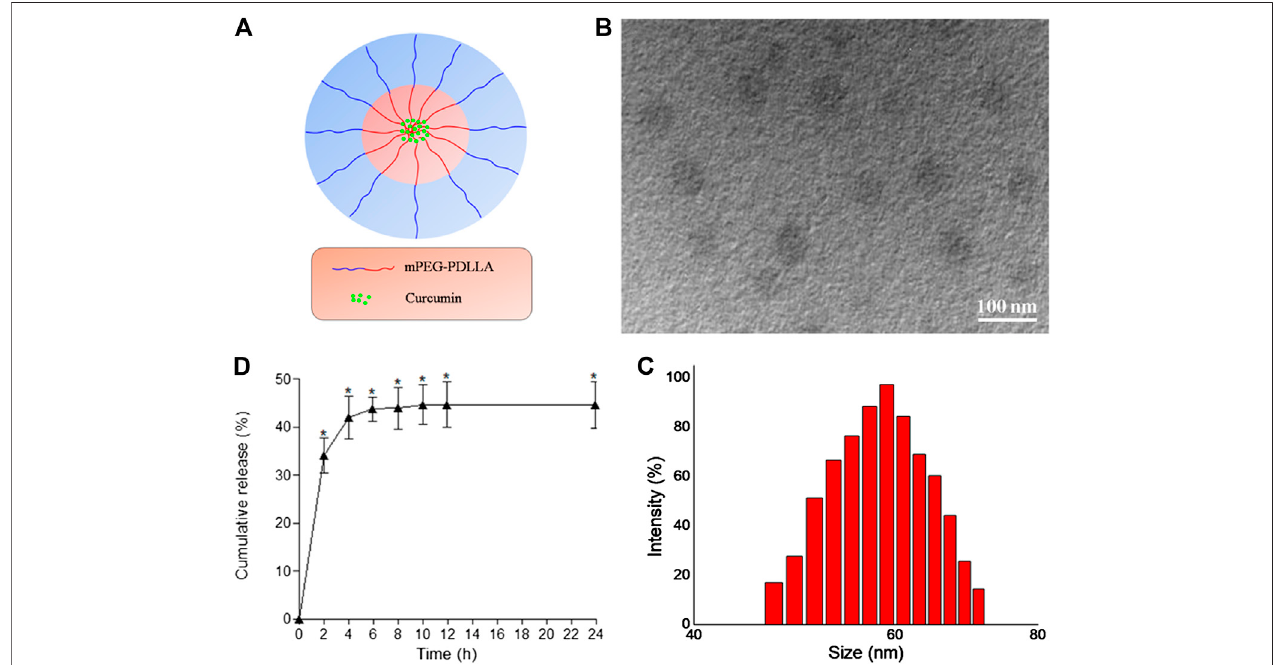
FIGURE1| CharacterizationofCUR-NPs (A) ThestructuralschemeofCUR-NPs (B) TEMimageofCUR-NPs (C) SizedistributionofCUR-NPsdeterminedbyDLS (D) Cumulative release pro fi les of CUR from CUR-NPs in PBS (pH 7.4) for 24 h.